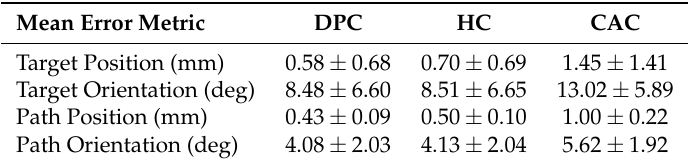
Figure 13. Performance results for the Expert User. Table 2. Expert user